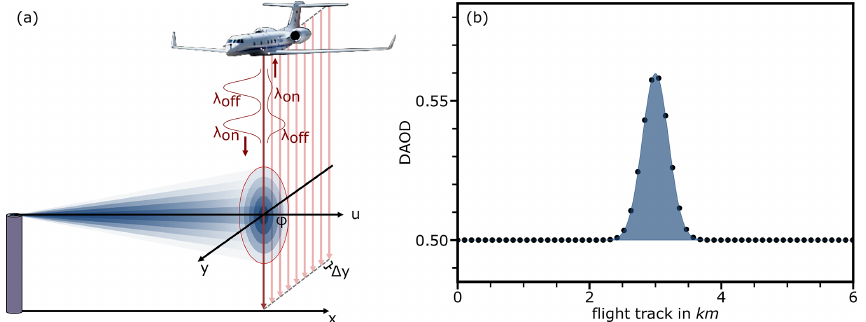
Figure 2. Crossing an exhaust plume illustrated by the example of CHARM-F carried on the aircraft HALO. (a) Two laser pulses are emitted towards the earth with a short delay. The laser pulse with the wavelength λ on is on the absorption wavelength of CO 2 , and the laser pulse with the wavelength λ off is not. By comparing the backscattered intensities, the DAOD can be calculated (see Sect. 2.1). An ideal exhaust plume of a point source has a Gaussian-shaped mean concentration distribution both horizontally and vertically. (b) A perpendicular crossing of the plume yields a Gaussian-shaped DAOD